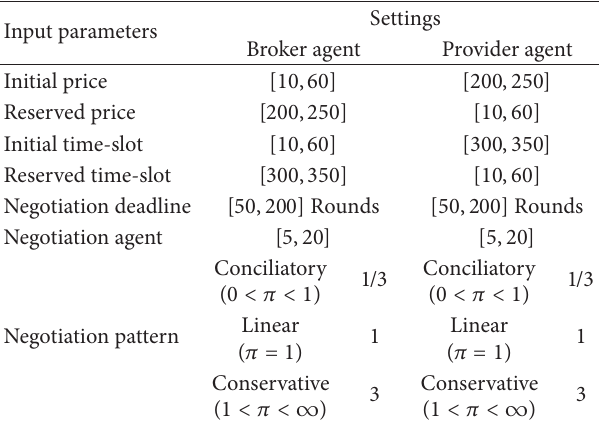
Table 1: Experimental settings of the negotiating